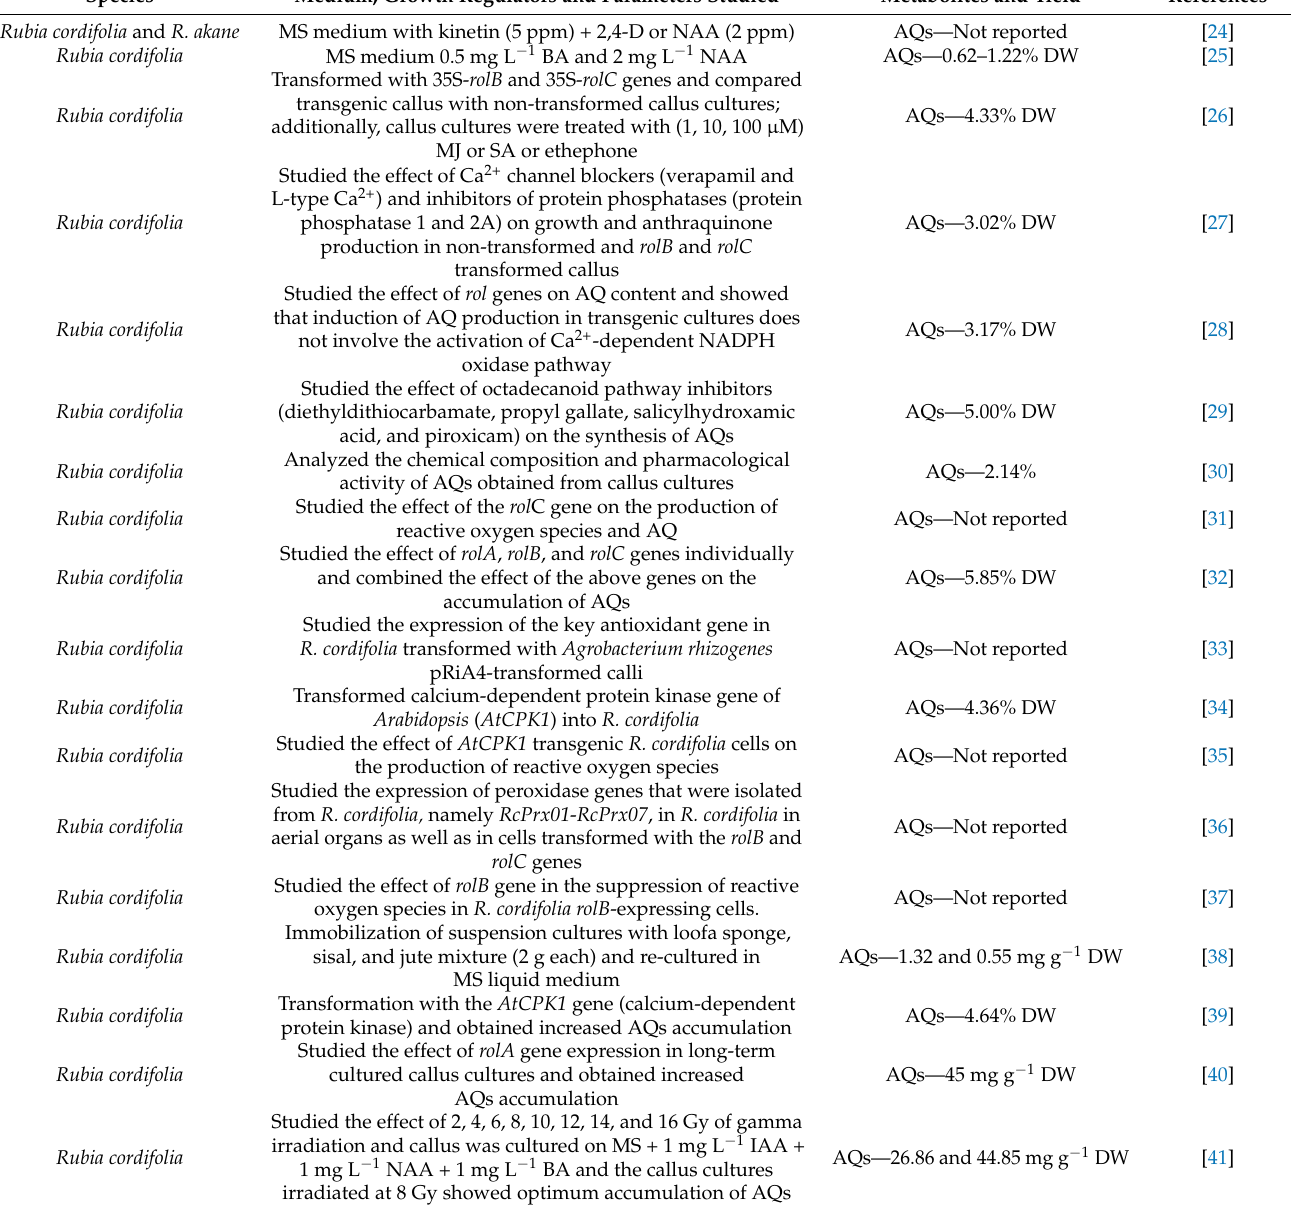
Table 2. Callus cultures for the production of anthraquinones (AQs) in Rubia